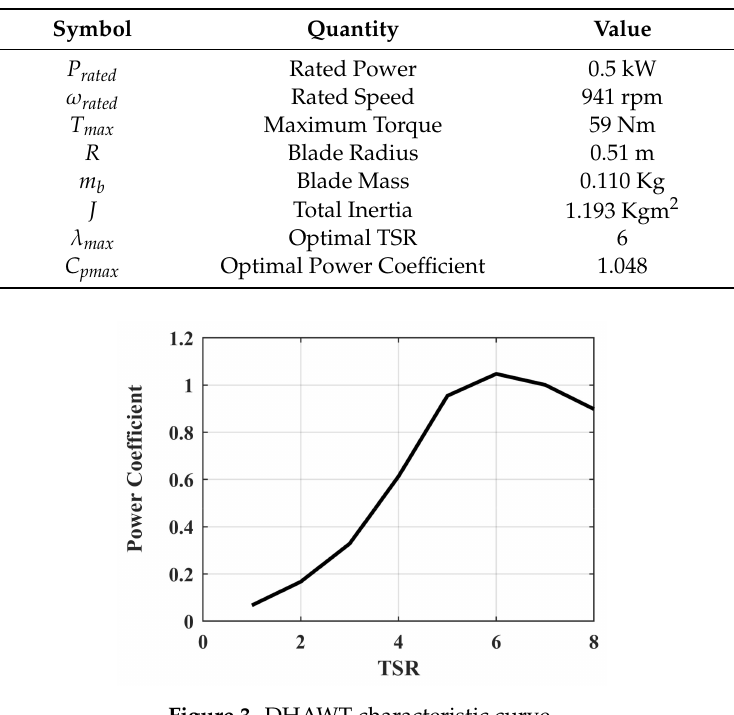
Figure 3. DHAWT characteristic